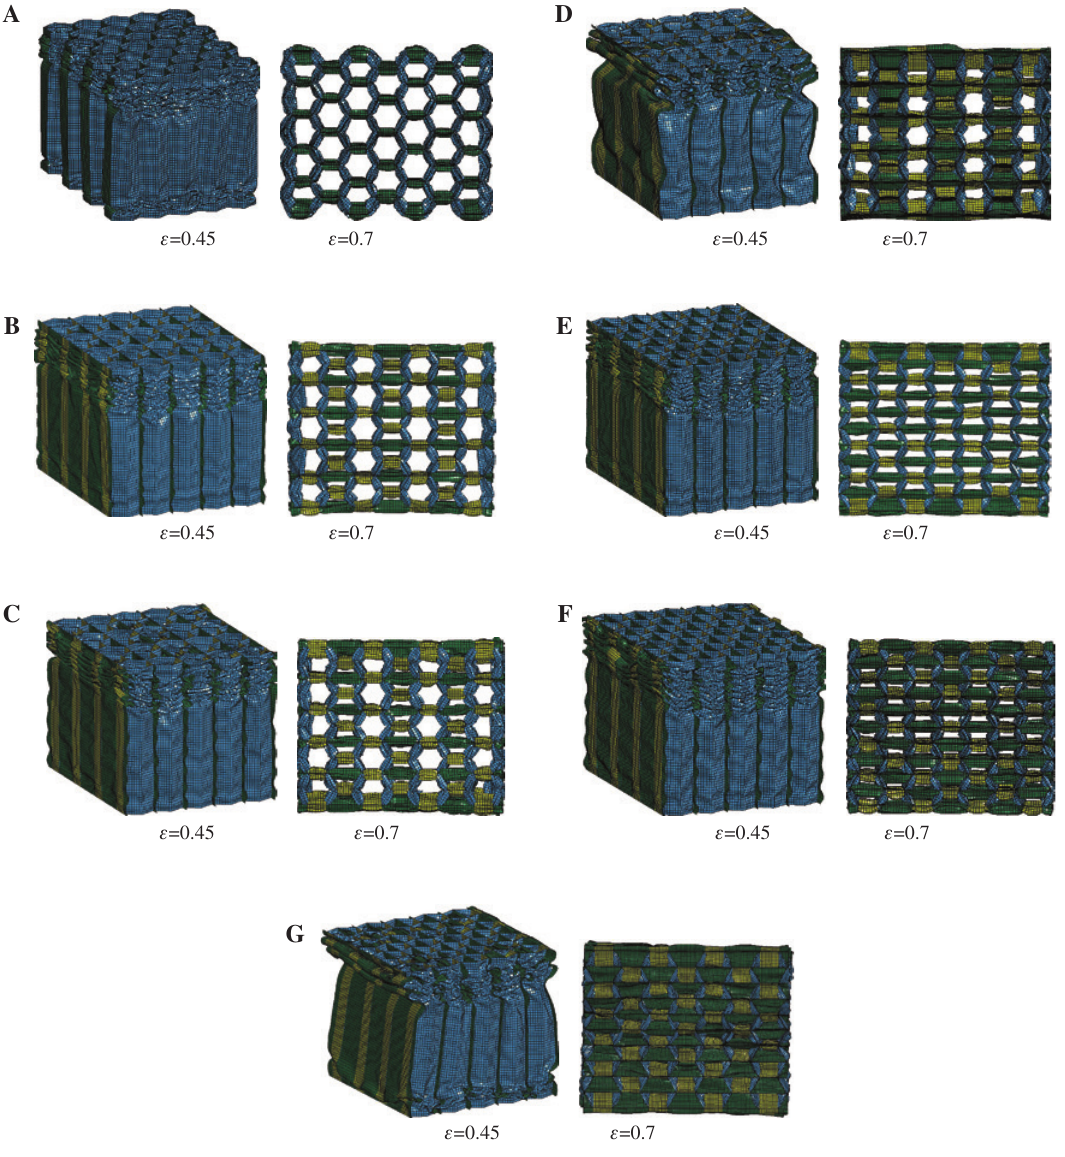
Figure 7: Typical deformation modes of HSPs. = t = 0.06 mm). (B) R1 ( t (A) R0 ( t 1 0